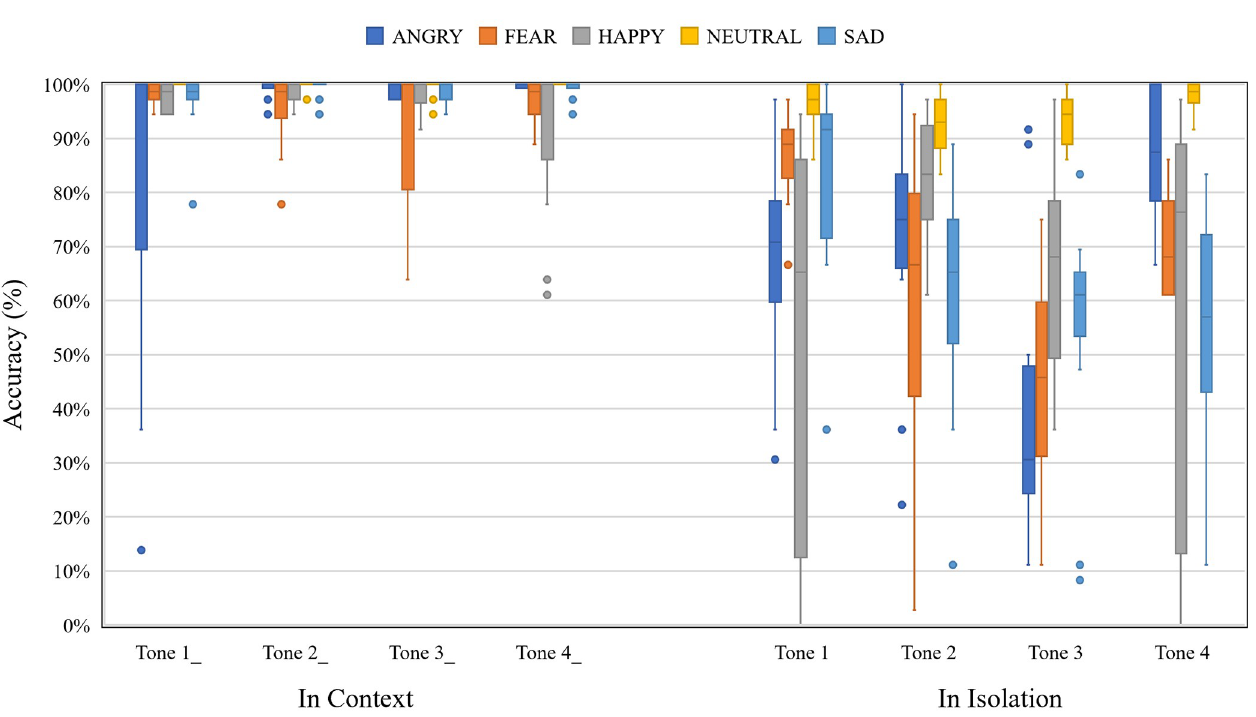
Fig 6. Boxplot showing the Mandarin tone identification accuracy as a function of Mandarin tone, emotion, and context.